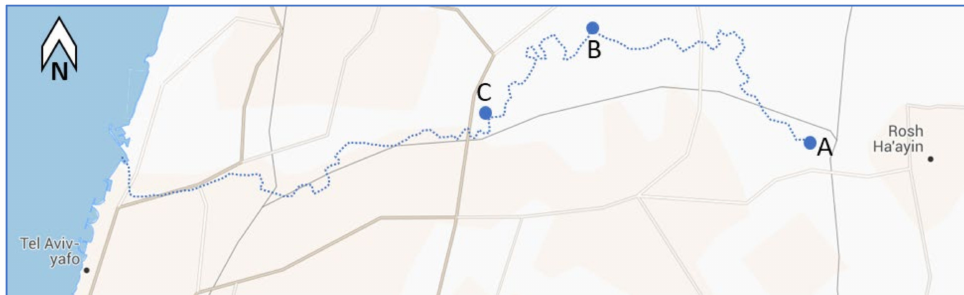
Figure 5. Study area map. (A) Source of the stream, from aquifer water pumps. (B) Discharge points of two WWTP. (C) Discharge point of a third WWTP. Note: background map is adapted from “Michelin